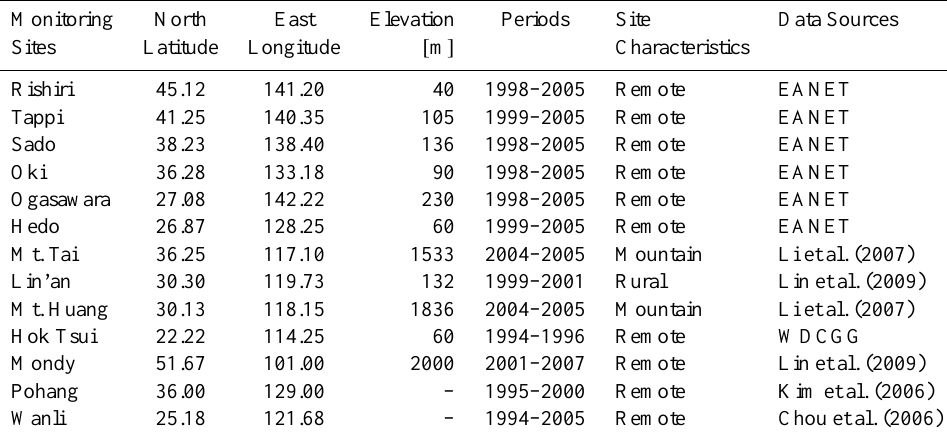
Table 2. General information of O 3 monitoring sites used for model evaluation in Sect. 3.1. Monitoring North East Elevation Periods